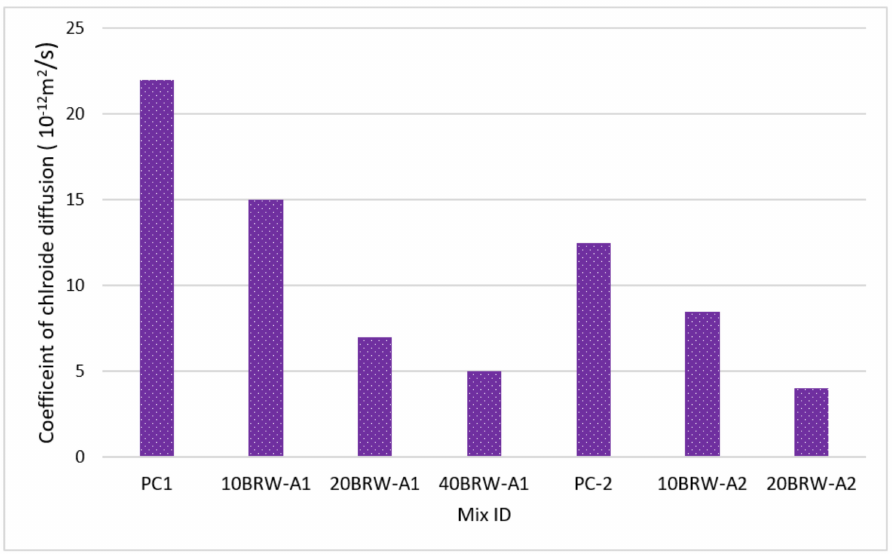
Figure 4. Coefficient of the chloride diffusion of samples at 28 days (data from reference